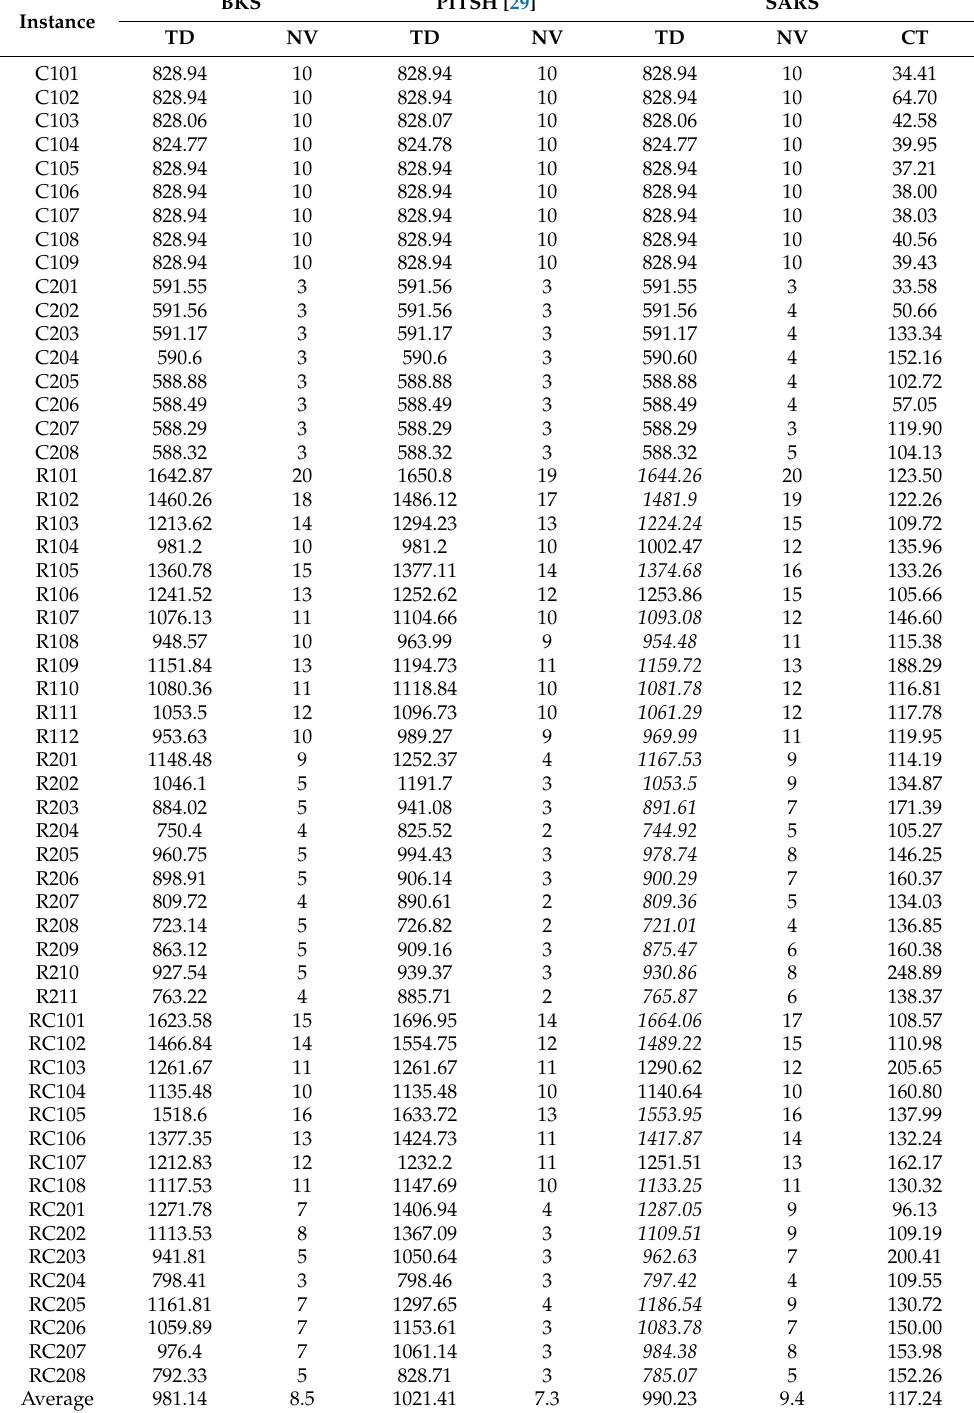
Table 7. Comparison of SARS with PITSH [29] and BKS on the VRPTW dataset with 100 customers (best solution for each